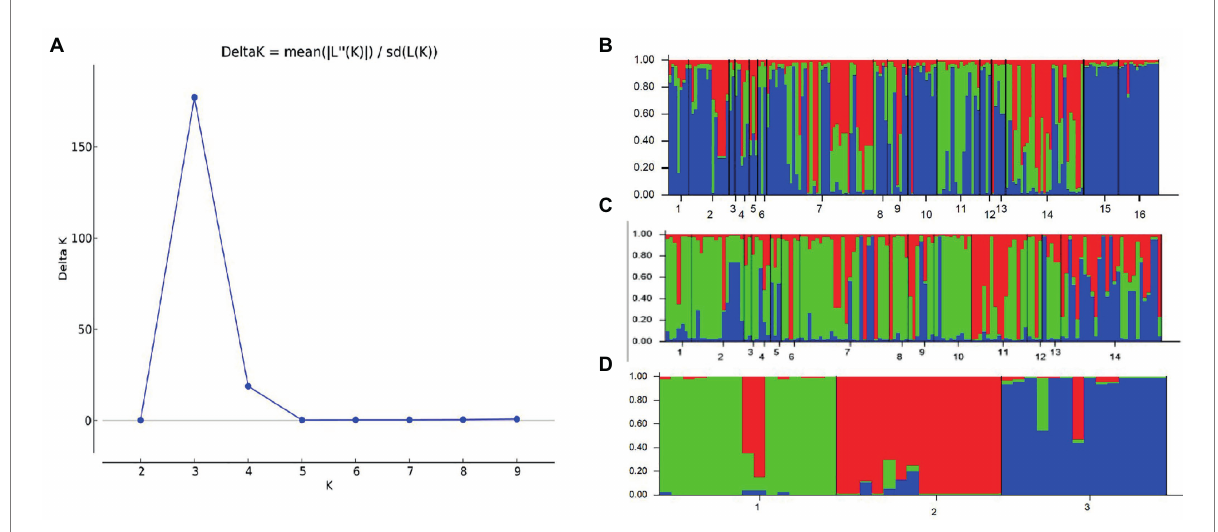
FIGURE 6 Estimation of population structure. (A) Optimum number of subpopulations was determined by using LnP(D) derived ∆ K. The maximum value of delta K was found to be at K = 3, suggesting division of the entire population into 3 subpopulations. (B) Assignment plots of Venturia carpophila from 14 peach producing provinces and 3 hosts with K = 3 performed in the program STRUCTURE. Black lines separate isolates from different locations. 1 = Beijing (BJ), 2 = Chongqing (CQ), 3 = Guangdong (GD), 4 = Guangxi (GX), 5 = Guizhou (GZ), 6 = Hebei (HeB), 7 = Hubei (HuB), 8 = Henan (HN), 9 = Jiangsu (JS), 10 = Sichuan (SC), 11 = Shandong (SD), 12 = Shanxi (SX), 13 = Yunnan (YN), 14 = Zhejiang (ZJ), 15 = Mume, 16 = Apricot. (C) Assignment plots of V. carpophila from 14 peach producing provinces with K = 3 performed in the program STRUCTURE. 1 = Beijing, 2 = Chongqing, 3 = Guangdong, 4 = Guangxi, 5 = Guizhou, 6 = Hebei, 7 = Hubei, 8 = Henan, 9 = Jiangsu, 10 = Sichuan, 11 = Shandong, 12 = Shanxi, 13 = Yunnan, 14 = Zhejiang. (D) Assignment plots of V. carpophila from 3 hosts with K = 3 performed in the program STRUCTURE, 1 = Peach, 2 = Mume, 3 = Apricot.